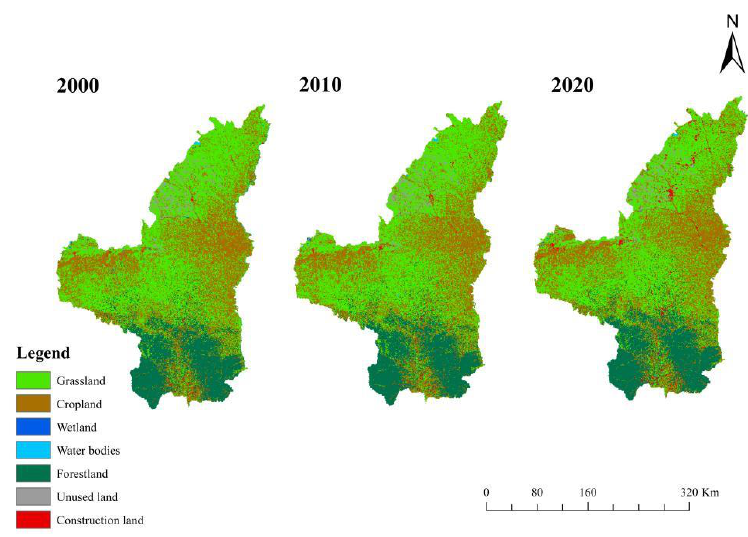
Figure 2. Land-use in the Loess Plateau of Northern Shaanxi.